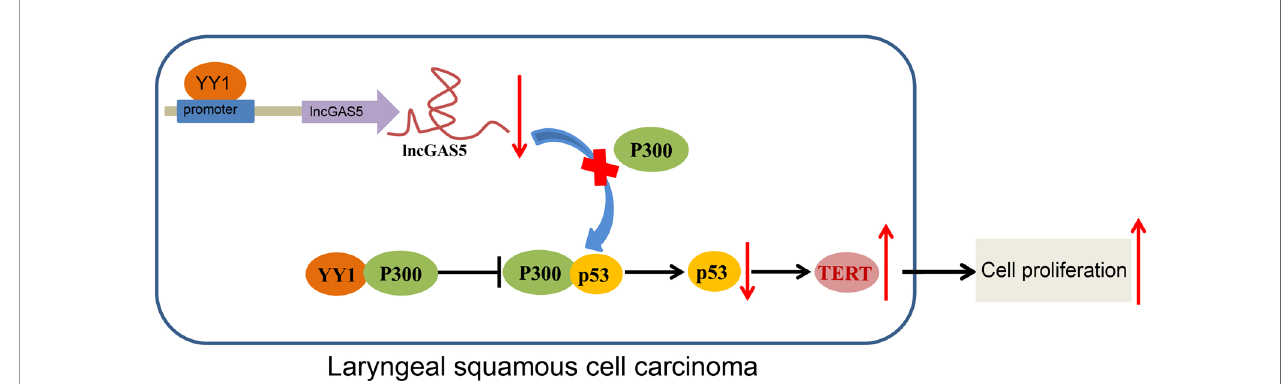
FIGURE 7 | Schematic diagram of the mechanism by which YY1 affects LSCC. YY1 inhibits the expression of GAS5 by binding to the GAS5 promoter, thereby reducing the stability of p53. By this mechanism, hTERT transcription is increased and the occurrence of LSCC is promoted. On the other hand, YY1 can directly interact with p300 to affect the stability of p53, thus upregulating hTERT transcription and promoting the occurrence